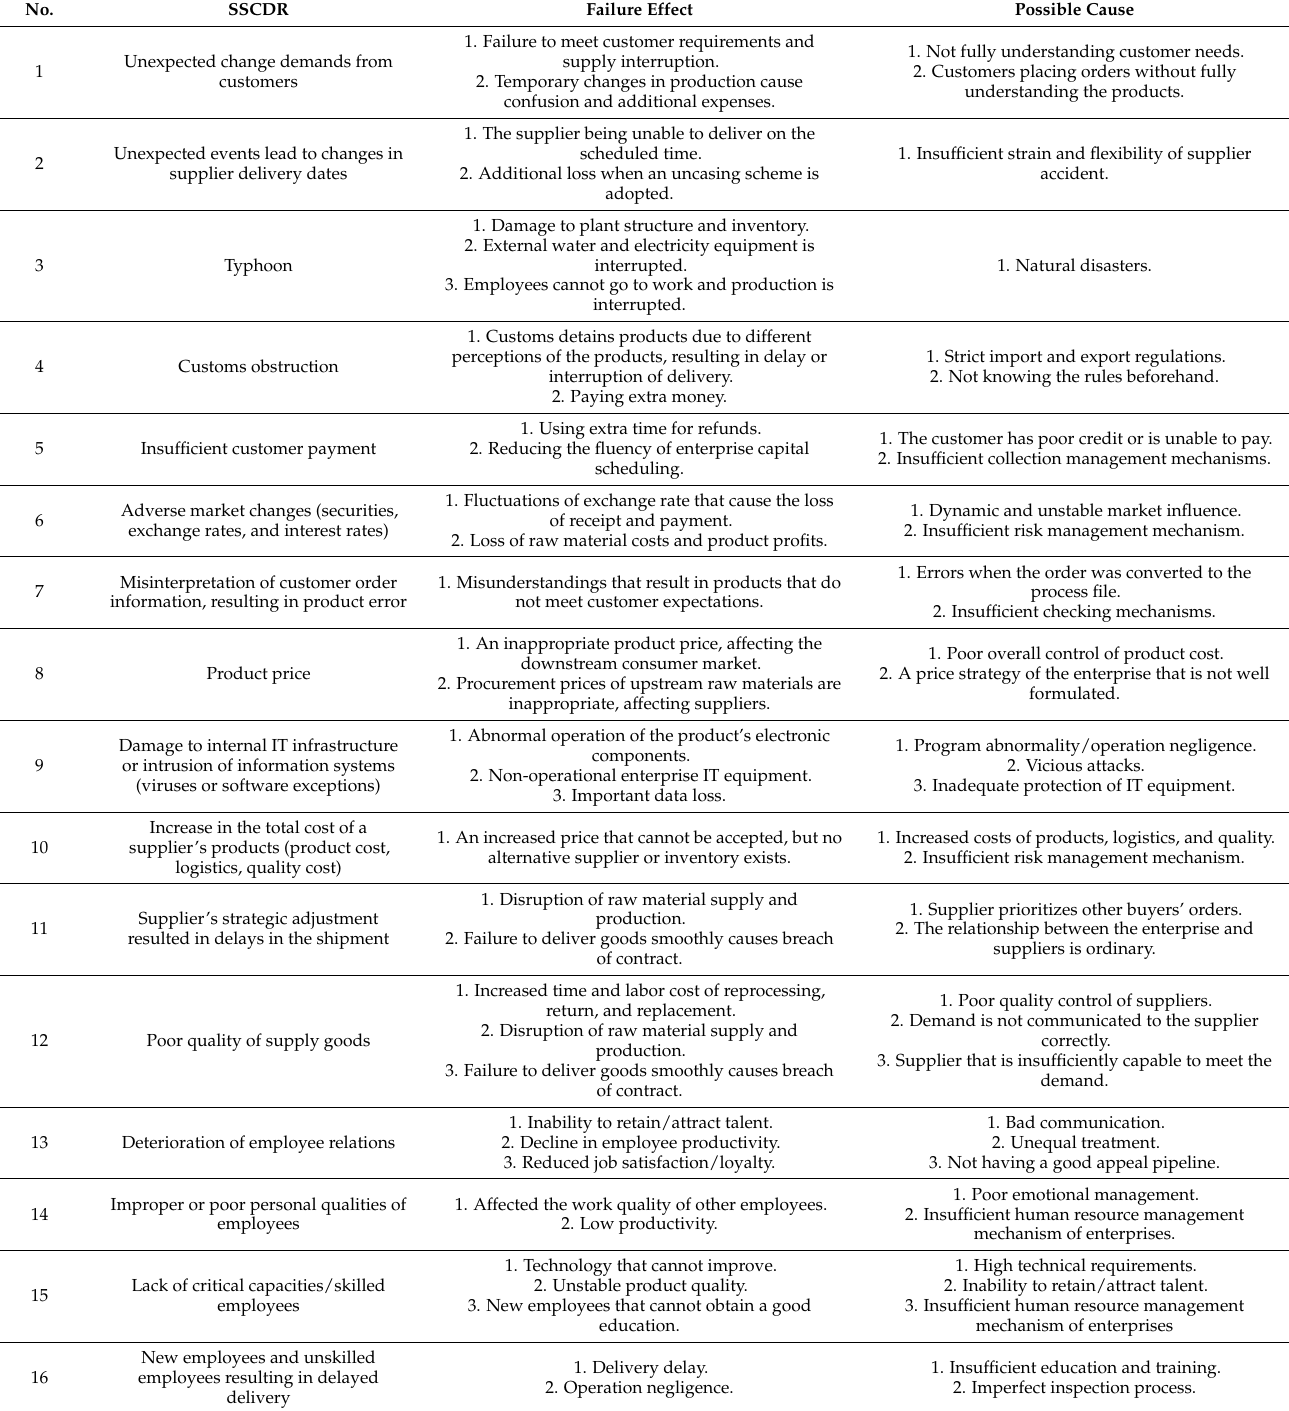
Table 2. Important SSCDRs selected by FGM and causes and